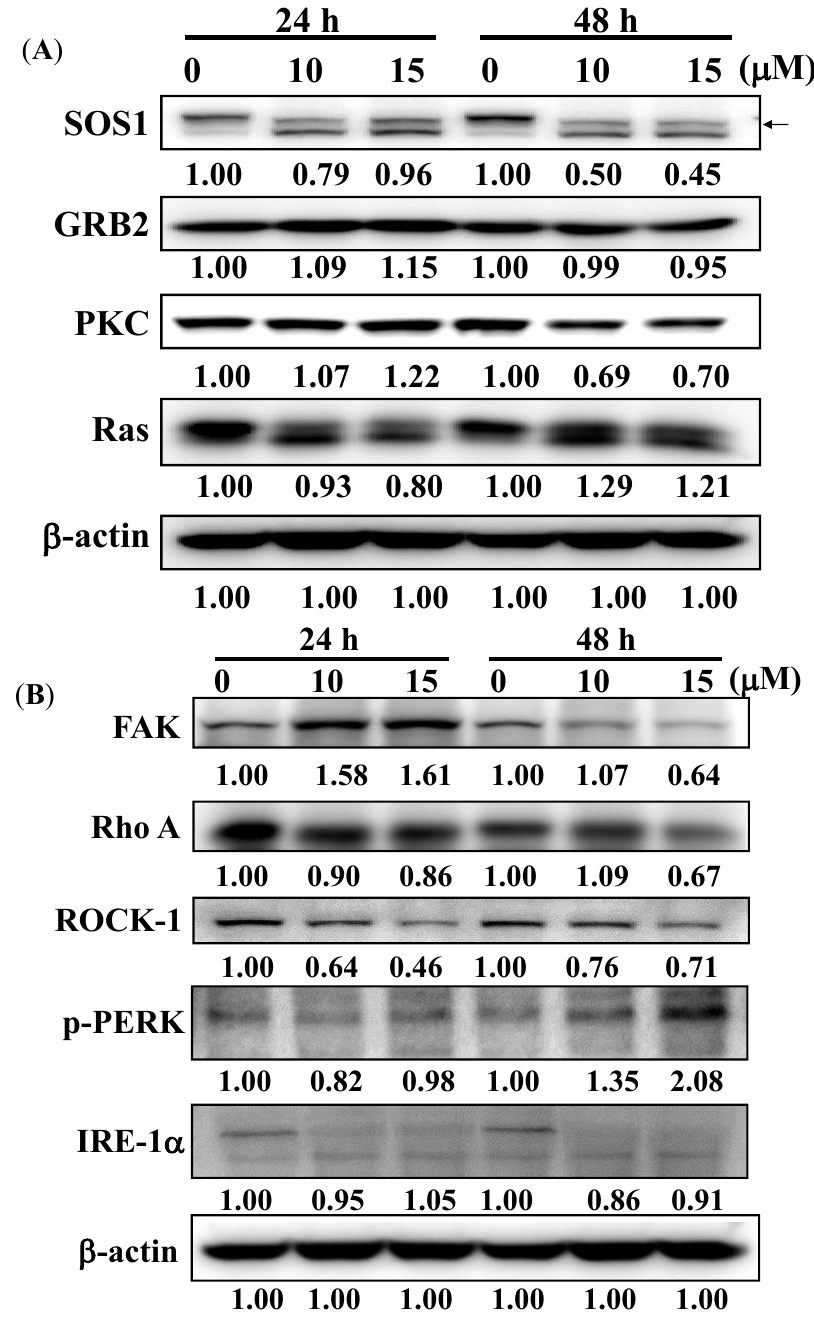
Figure 6. Deguelin affect the levels of associated proteins in migration and invasion of U-2 OS cells. U-2 OS cells were treated with deguelin (0, 10, 15 μM) for different periods of time and then cells were collected and the total protein extracts were prepared and determined as described in the Experimental Section. The levels of SOS1, GRB2, PKC and Ras ( A ), FAK, Rho A, ROCK-1, p-PERK and IRE-1α ( B ), PI3K, p-AKT(Thr308), p-AKT(Ser473), NF-κB p65, iNOS and COX-2 ( C ), MEKK3, MKK7, p-ERK1/2, p-JNK1/2, p-p38 and p-c-JUN ( D ), TIMP1, TIMP2, UPA ( E ), MMP-2, MMP-9, MMP-13, MMP-1 and VEGF ( F ) expressions were estimated by western blotting as described in the Experimental